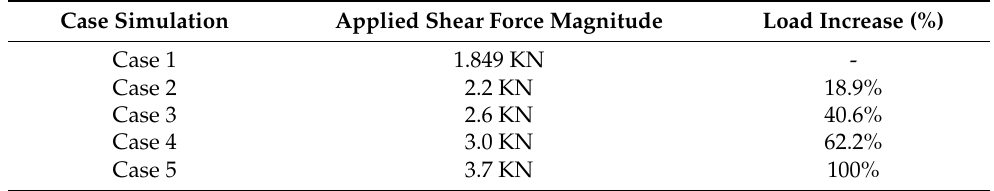
Table 2. Case simulation scenarios.